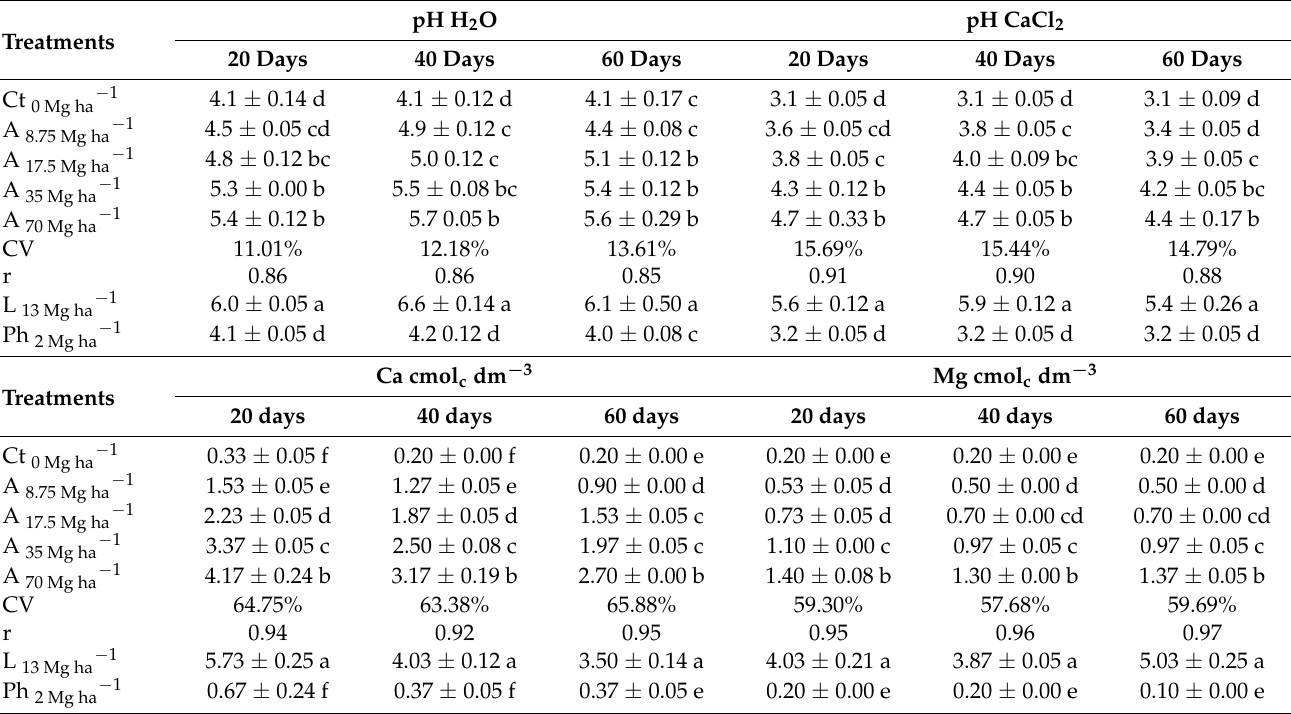
Table 3. Chemical properties of Yellow Latosol as a function of the application of ash from Amazonian biomasses, lime, and phosphate fertilizer. The mean values and standard deviations of the pH and exchangeable cations obtained after the three incubation times are